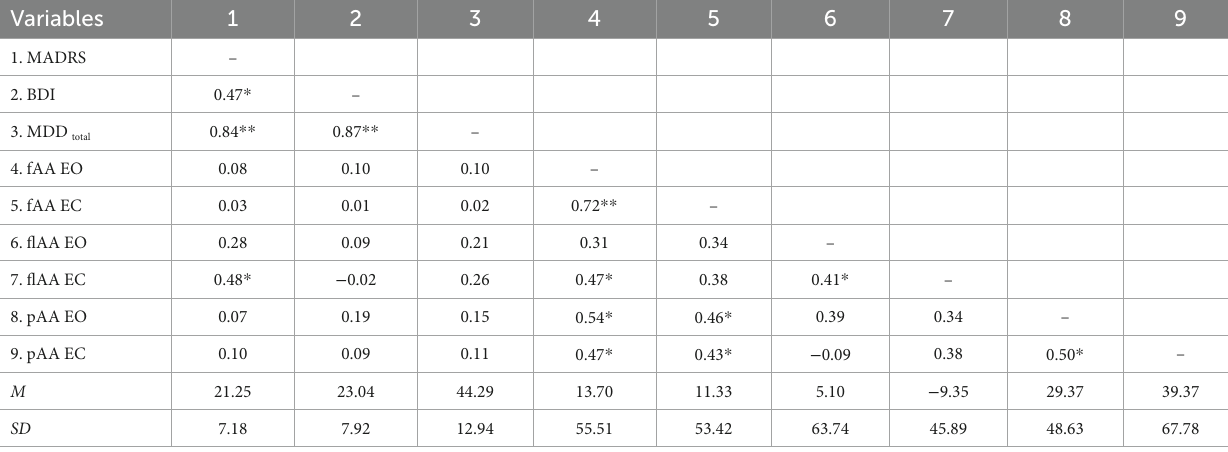
TABLE 1 Means, Standard Deviations, and Correlations Between Measures.